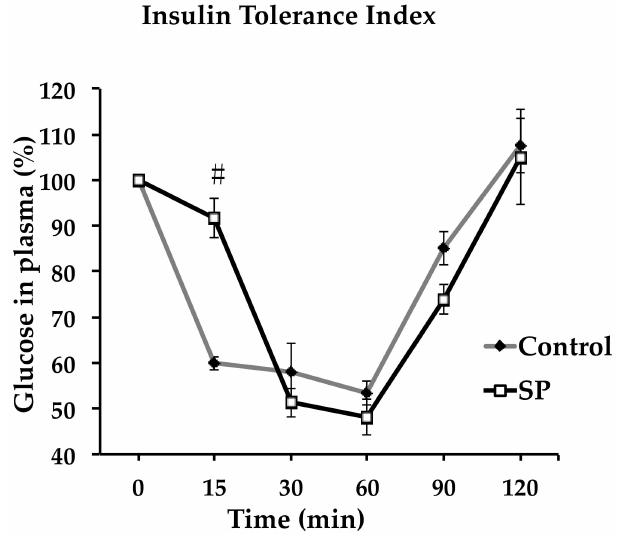
Figure 3. Insulin tolerance index in control and sucrose period rats. Measurements were taken at different times: 15, 30, 60, 90 and 120 min. 100% glucose in plasma corresponds to the value in mg/dl reported in Table 2. SP, sucrose period. Data represent mean ± SEM, # p < 0.05, n = 6.